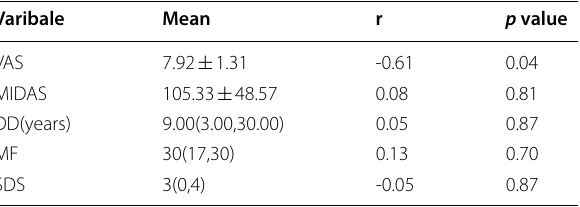
Table 2 The correlation analysis of the CBF value of the left NAcc with the clinical